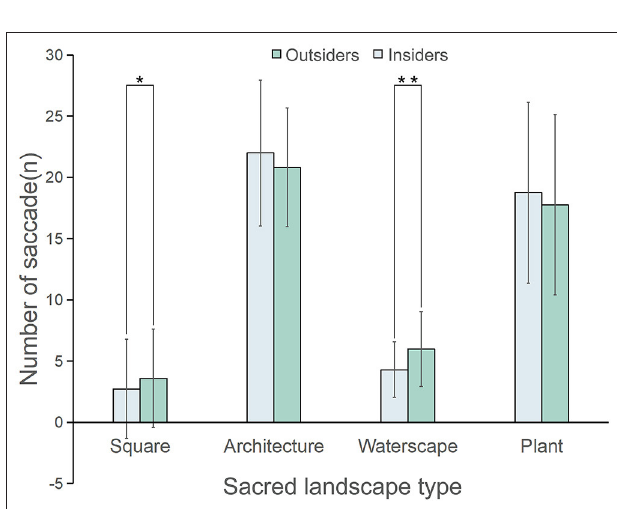
FIGURE 5 | Comparison of the average fixation duration between the outsiders and the insiders (* p < 0.05, ** p < 0.01); the data are shown as means (SD). N = 45 for each group.